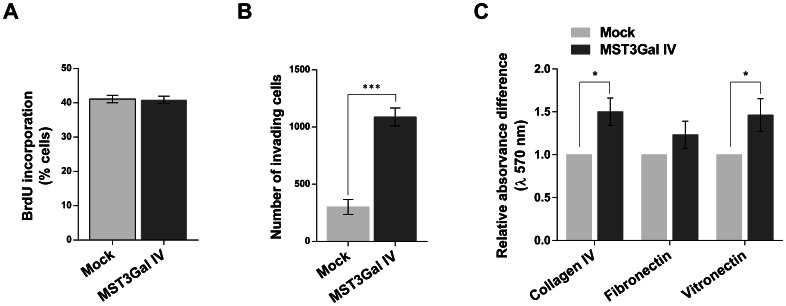
SLex overexpression induces cell invasion and increases matrix-cell adhesion in vitro.
A - BrdU proliferation assay in transfected cells. After 50% confluence, cells were incubated for 30 min with BrdU reagent and fluorescent labeled for proliferative index measurement. No differences were found between the different cell lines. B - Cell invasion assay on Matrigel chambers. Cells were seeded on Matrigel-coated filters inserted into two-compartment chambers and invading capacity was measured by counting the number of cells that invade, through the Matrigel-coated filter, 6 hour after incubation. MST3Gal IV cells demonstrated an invasive phenotype presenting a significant increased number of invasive cells when compared with MOCK cells (***p < 0.001). C - Cell adhesion to ECM proteins. Adhesion potential of cells was assessed by incubating cells 30 minutes in pre-coated plates with collagen IV, fibronectin and vitronectin. Results demonstrate an increased adhesion of SLex expressing cells to collagen IV (*p < 0.05 MST3Gal IV versus Mock) and vitronectin (*p < 0.05 MST3Gal IV versus Mock) matrix proteins. No statistical difference was found in the adhesion capacity of cells to fibronectin. Results are presented as means ± SD.